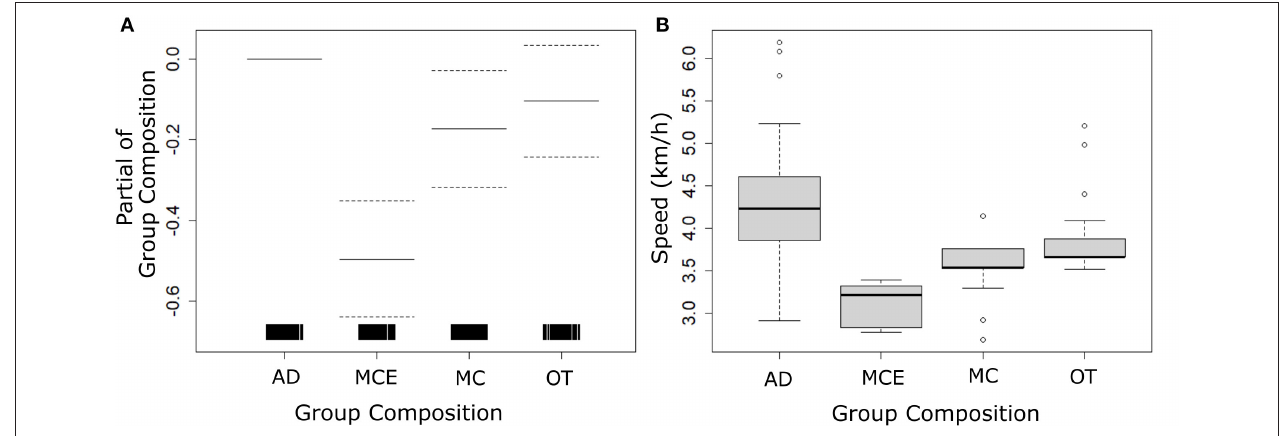
FIGURE 2 | Results from the best fit generalized additive model (GAM) for humpback whale swim speed showing (A) model parameter estimates of group composition (AD-adult, MCE-mother-calf-escort, MC-mother-calf; OT-other) and (B) model predicted swim speeds based on group composition. Dashed lines in image A represent the 95% confidence intervals of the parameter estimate, and vertical ticks indicate the locations of observations (i.e., a rugplot).